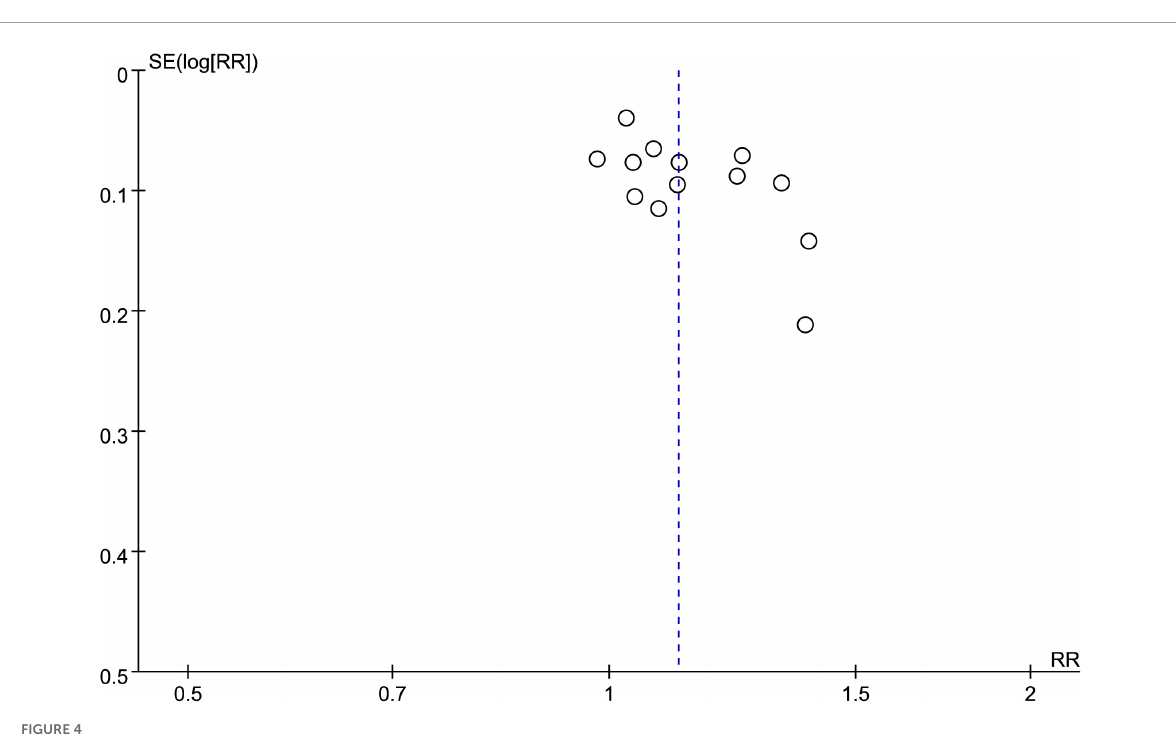
FIGURE4 Funnel plot on response rate indicating a low risk of publication